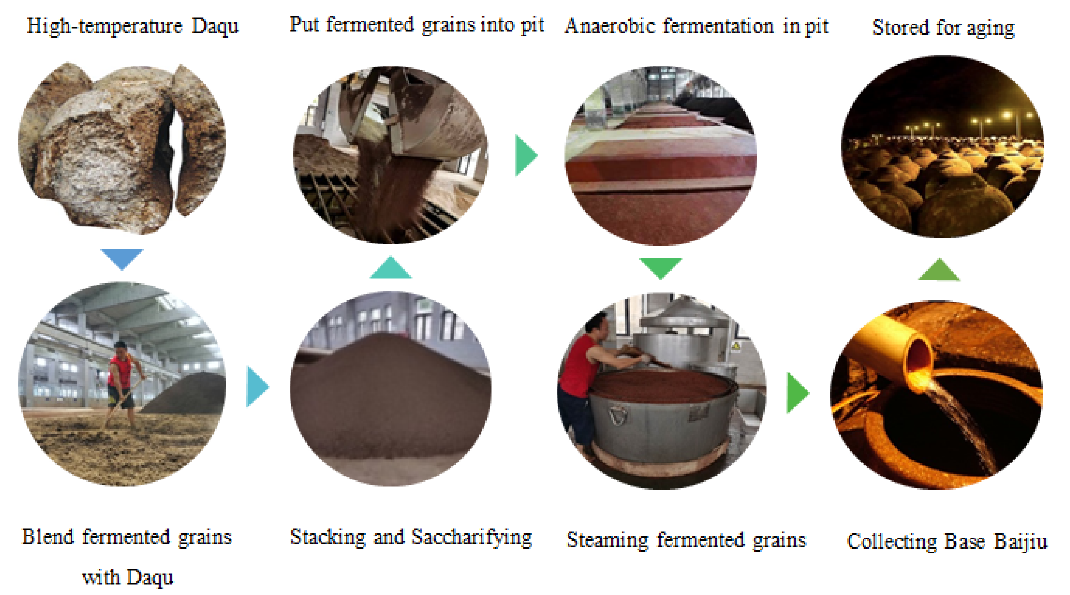
Figure 1. The main producing process of Sauce-aroma Baijiu.